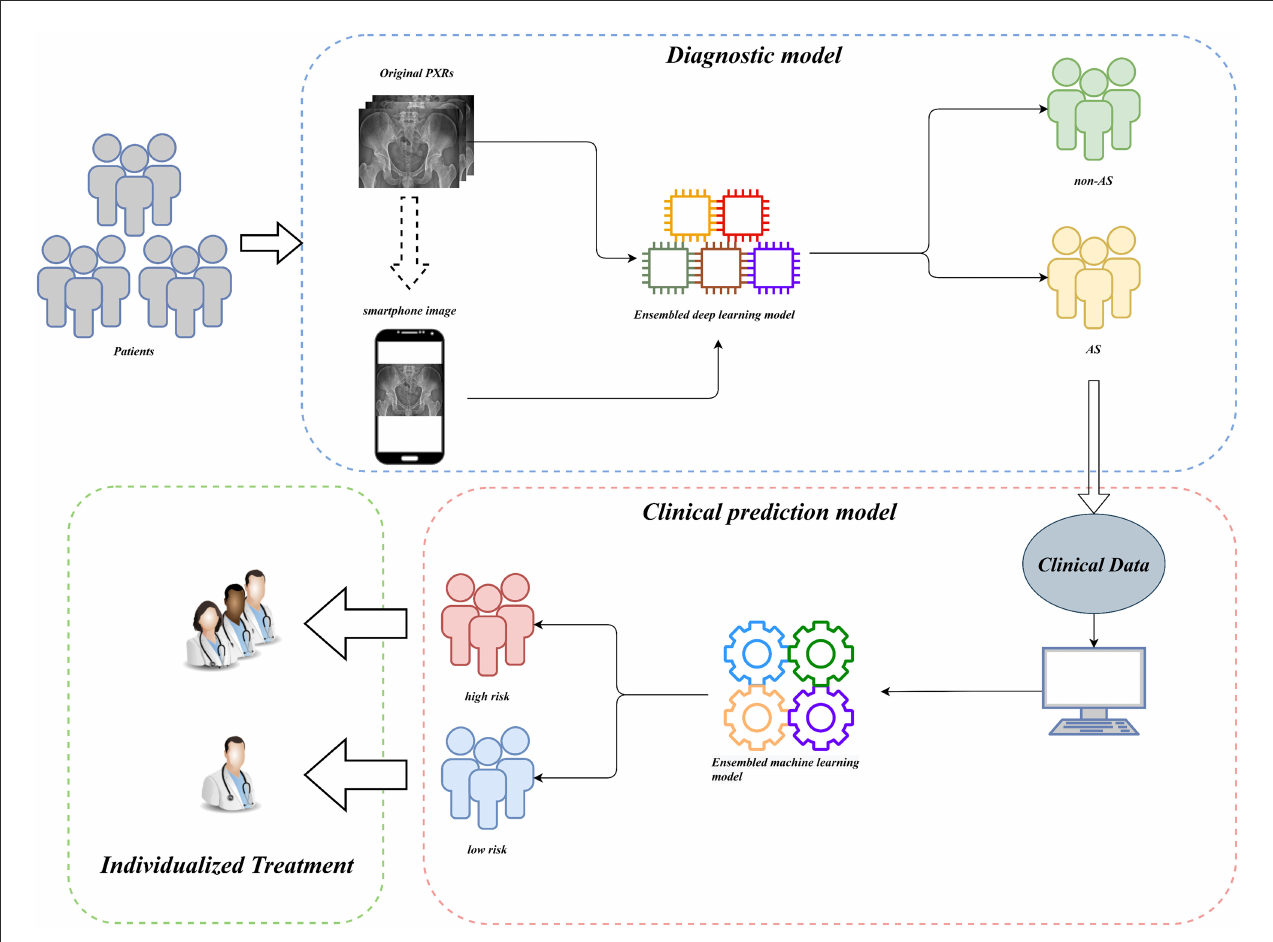
FIGURE8 Workflow diagram of our AI system. Our AI-assisted system enables a one-stop service for diagnosis and triage.